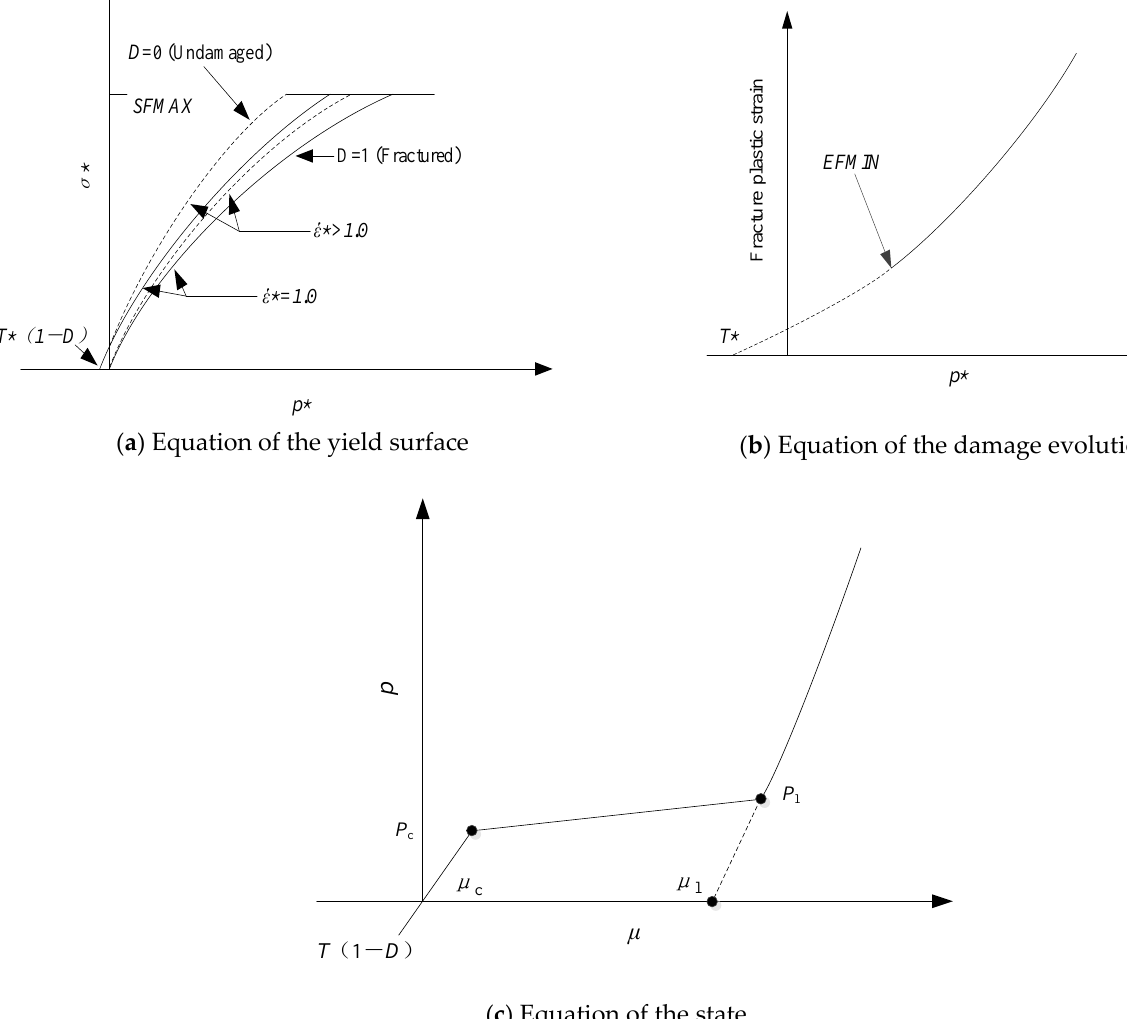
( c ) Equation of the state. Figure 12. The HJC model. Figure 12. The HJC